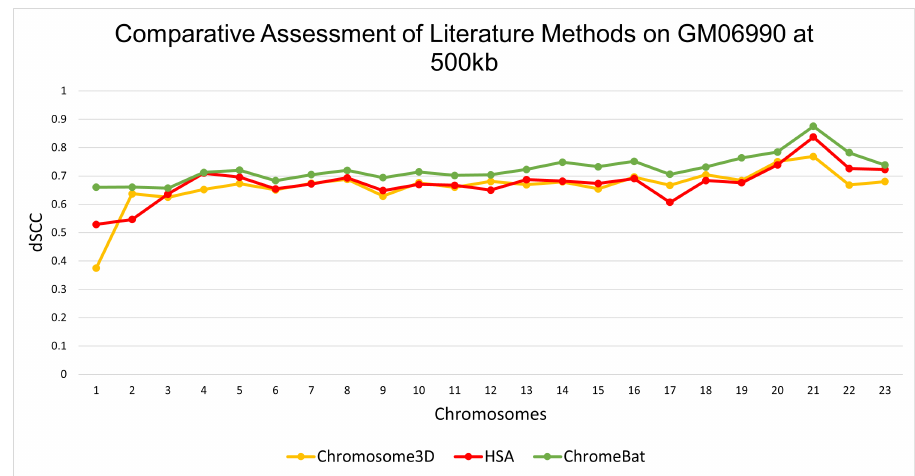
Figure 6. Comparative Assessment of Metaheuristic Methods on GM06990. A comparison of the distance Spearman Correlation Coefficient (dSCC) between metaheuristic methods Chromosome3D, HSA, and ChromeBat. This experiment is performed on the first 23 chromosomes of the GM06990 cell line at 500 kb resolution using restriction enzyme HindIII.